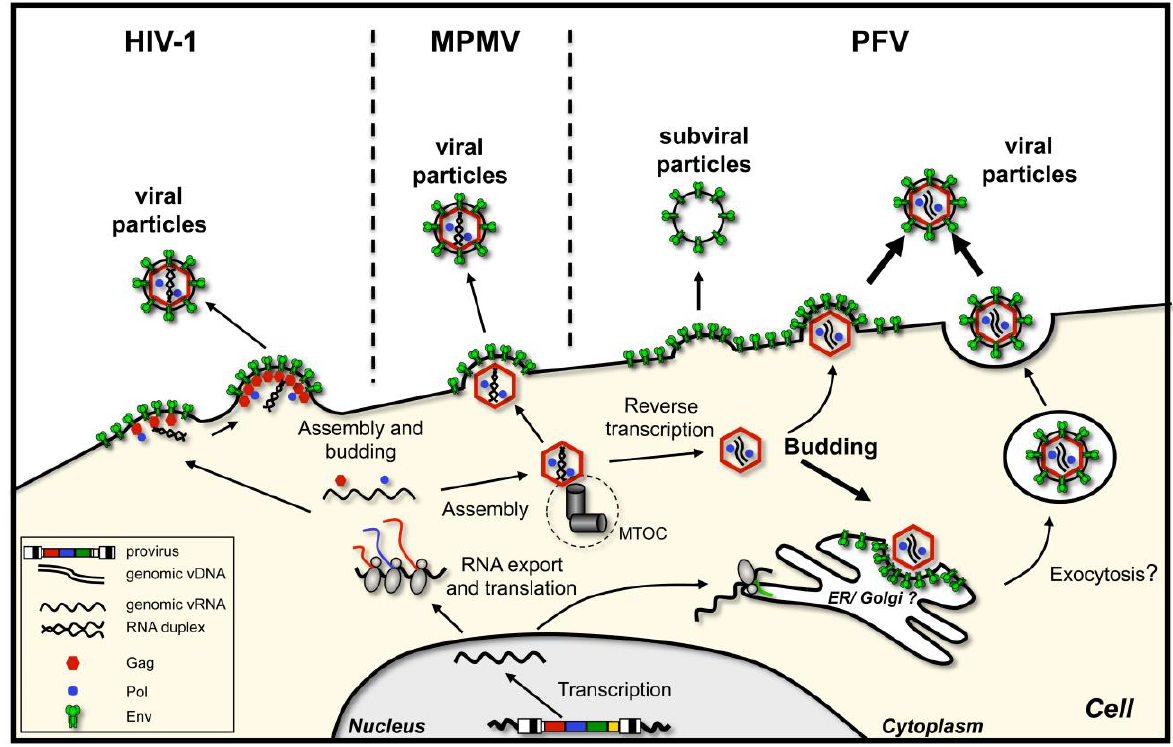
Figure 1. Retroviral capsid assembly and budding strategies. Schematic illustration of the capsid assembly and budding strategies of C-type (human immunodeficiency virus type 1, HIV-1), B/D-type (Mason-Pfizer monkey virus, MPMV), and foamy viruses (prototype foamy virus,